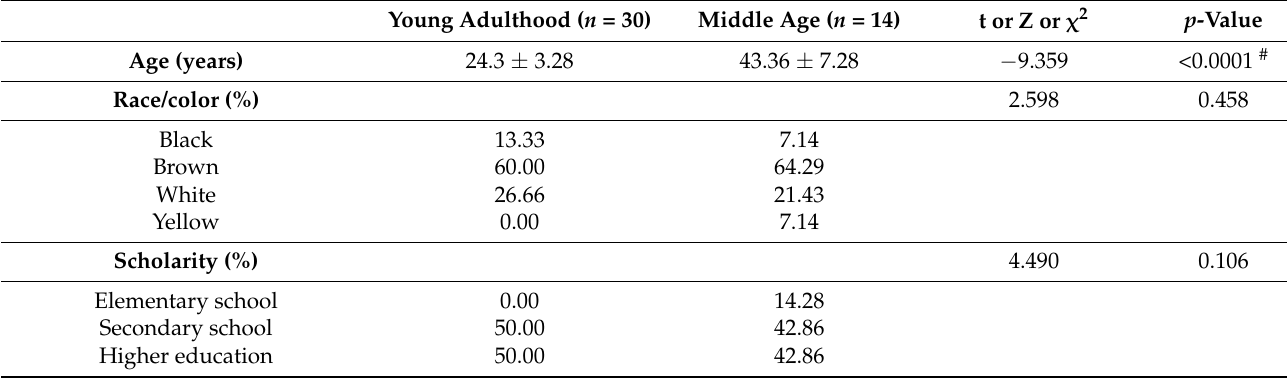
Table 1. Social and anthropometric factors in the different